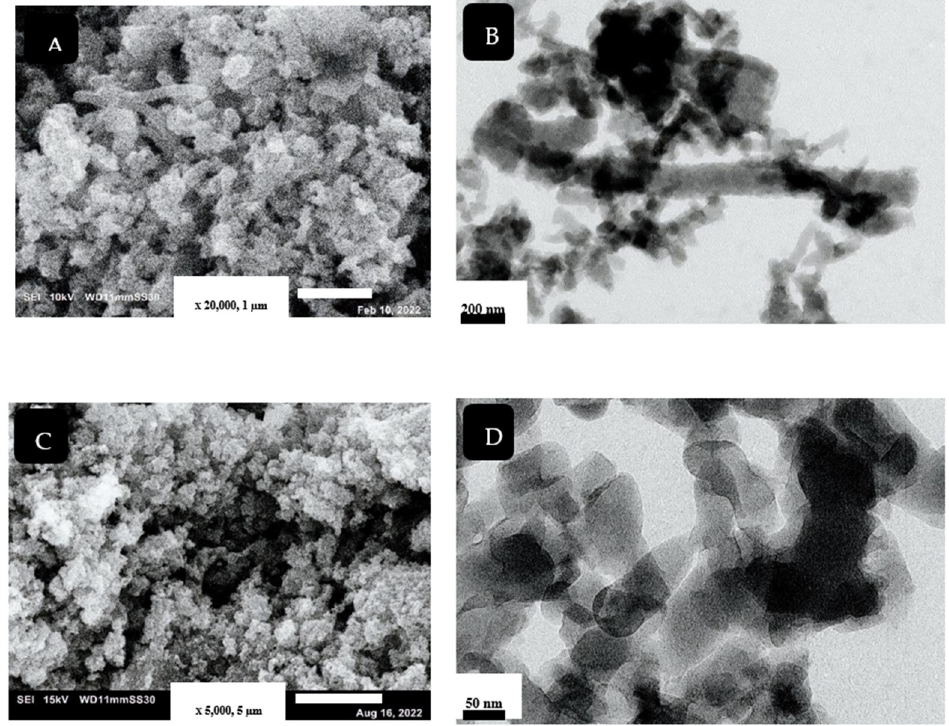
Figure 2. SEM and TEM images for PANI ( A , B ) and PANC ( C , D ), respectively.